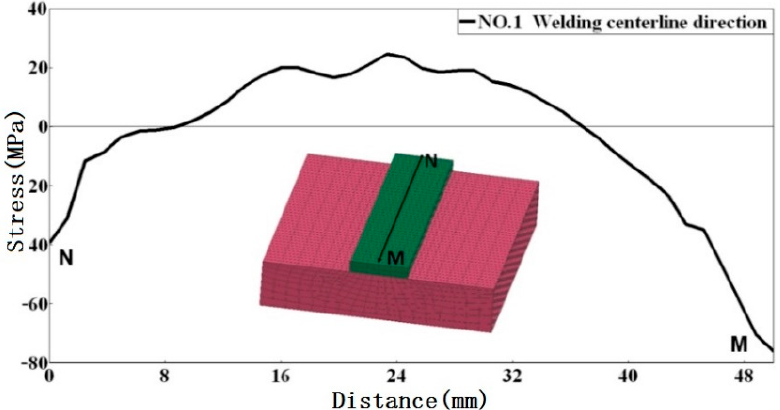
Figure 15. Residual stress distribution curve on the center line of the weld.